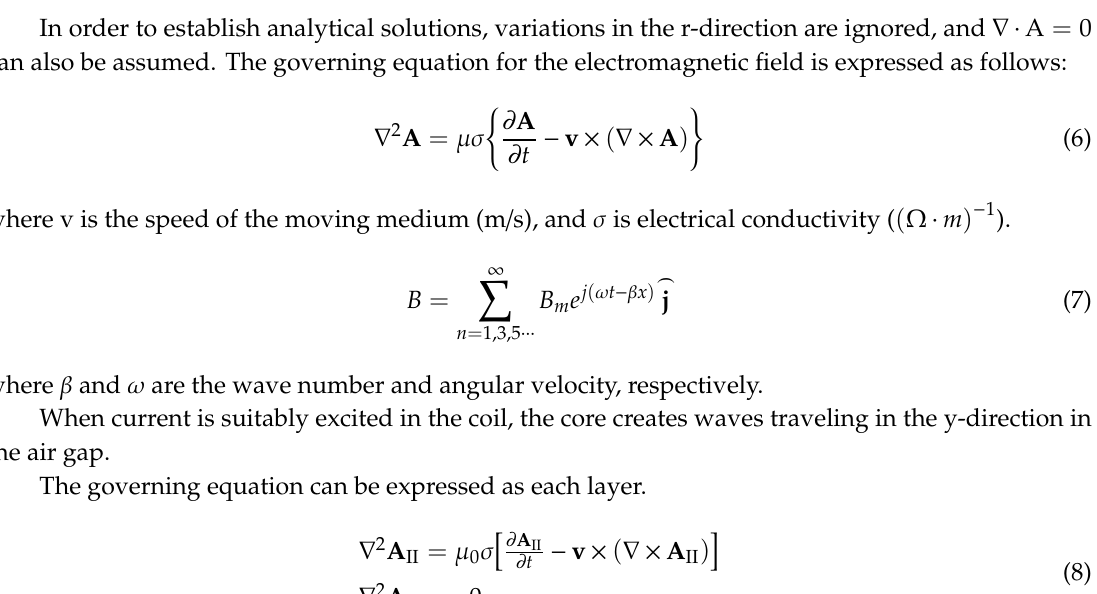
Figure 5. Geometric modeling for theoretical analysis of the proposed gripper.